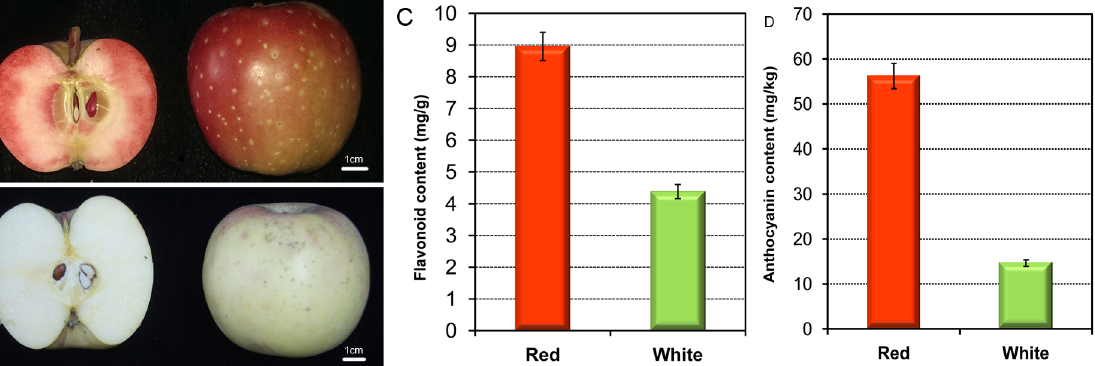
Fig 1. Red- and white-fleshed apples at the ripe stage used for RNA-Seq. (A)Red-fleshed apples in the F 1 population. Scale bar = 1cm. (B) White-fleshed apples in the F 1 population. Scale bar = 1cm. (C) Flavonoid content in red- and white-fleshed apples. (D) Anthocyanin content in red- and white-fleshed